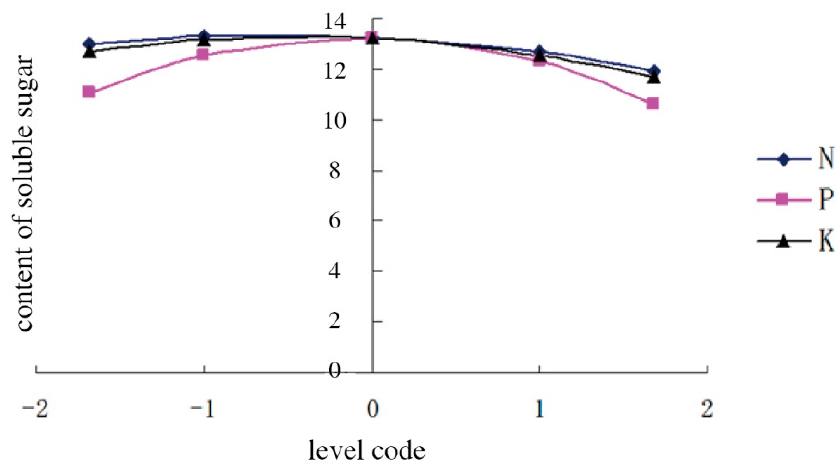
Figure 3. The effect of the application of N, P, and K fertilizers on the content of soluble sugars in melon.